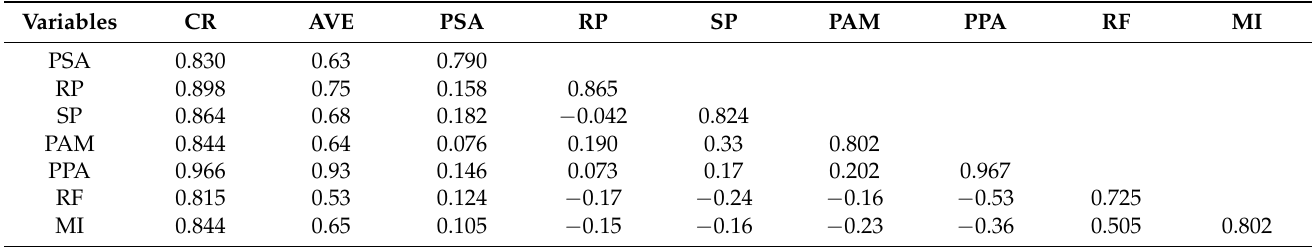
Table 3. Validity